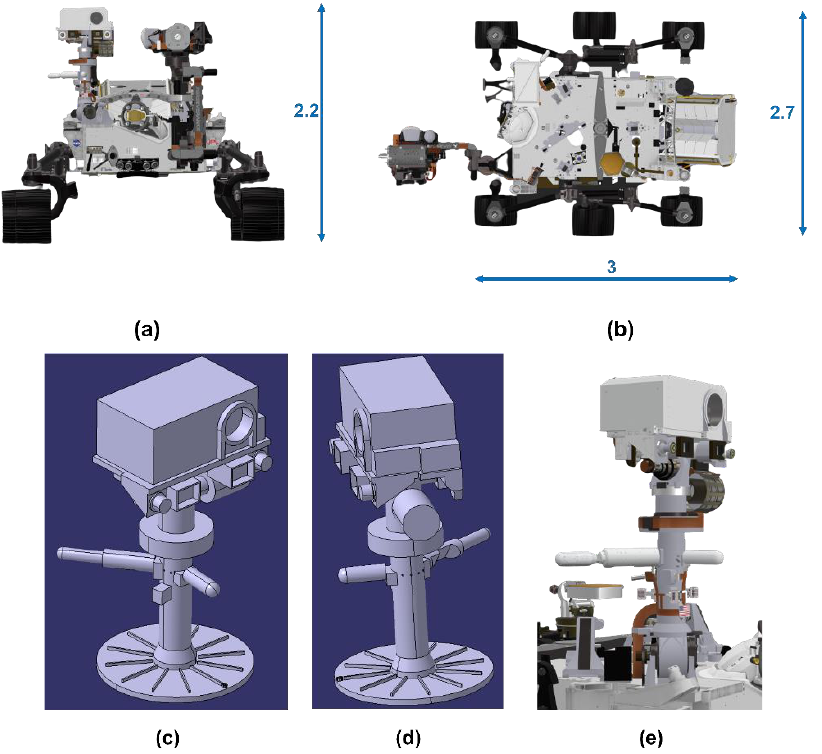
Figure 2. Details of the Mars rover Perseverance . ( a , b ) Main dimensions of the real rover, in meters; ( c ) left view of the final model of the mast and booms; ( d ) right view of the final model of the mast and booms; ( e ) detailed view of the mast and booms, from [23].